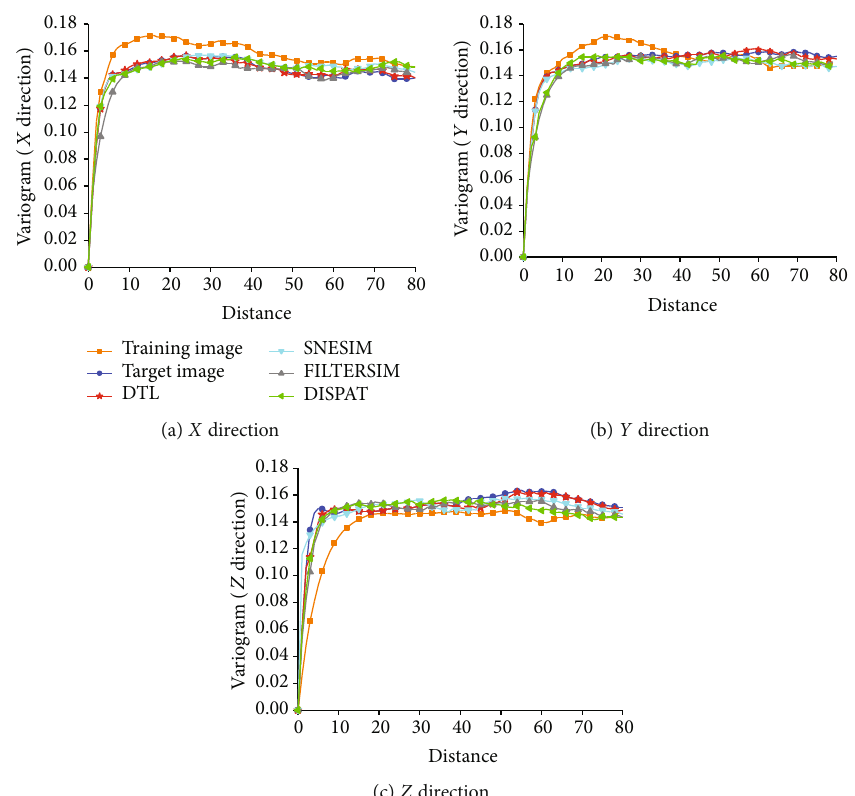
Figure 25: Variogram curves of reconstructed shale images by 5% conditioning data using SNESIM, FILTERSIM, DISPAT, and DTL in three